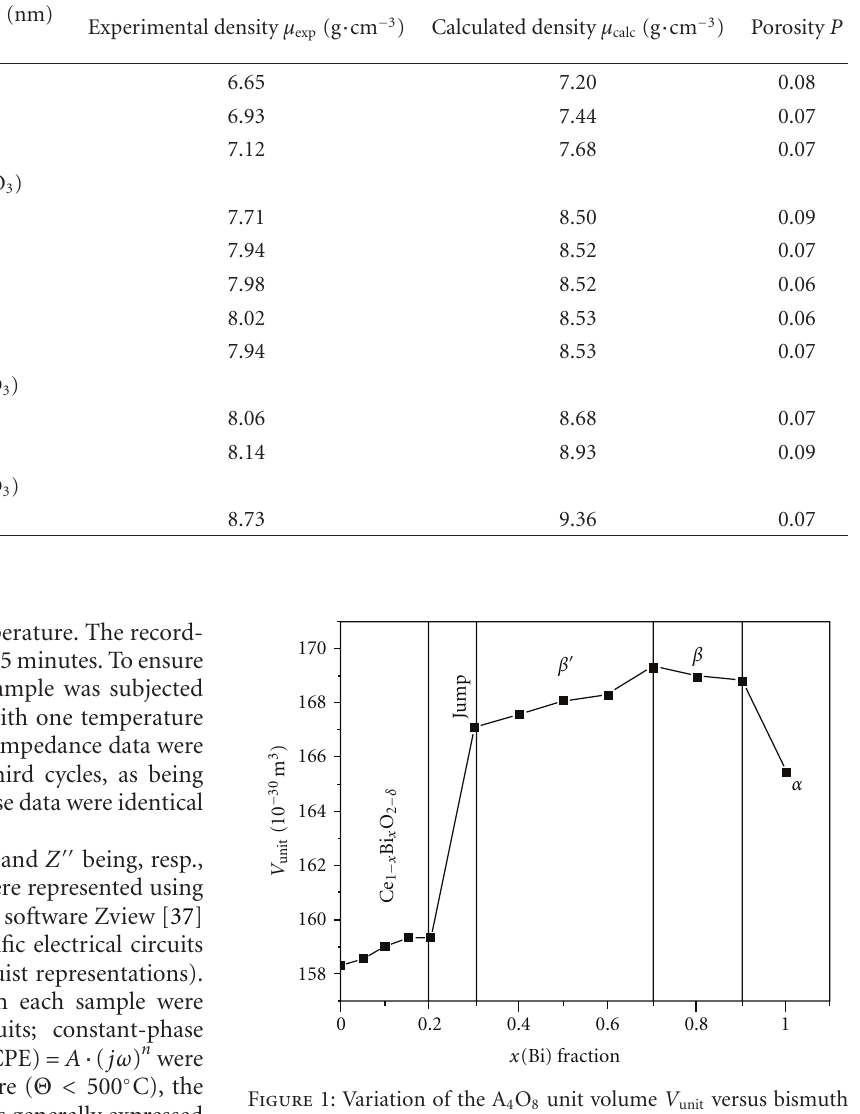
Table 1: Sample characteristics (densities, grain sizes, and porosities).